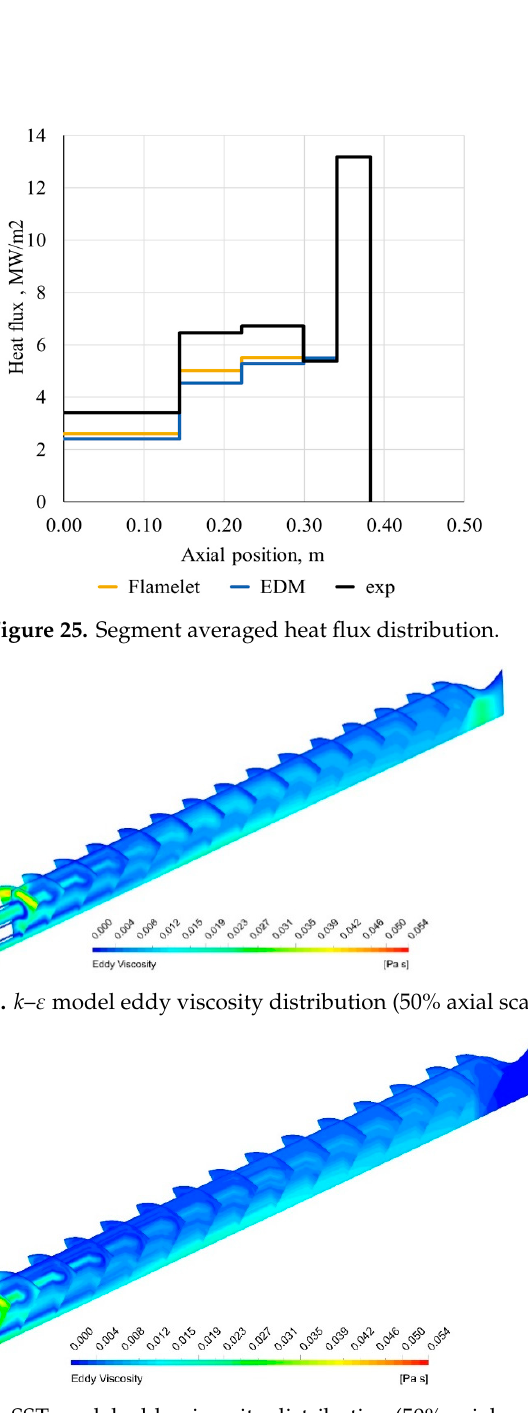
Figure 27. SST model eddy viscosity distribution (50% axial scaling).